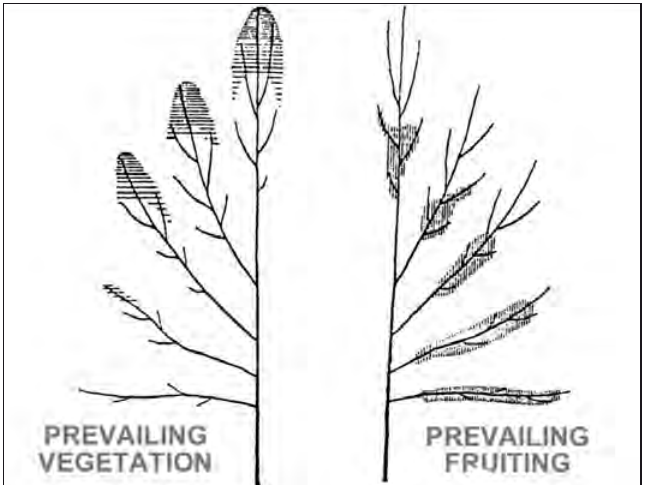
Fig. 6 - In the tree canopy the polymorphims of axes is differently lo - cated. In some parts vegetative structures prevail and in others reproductive structures are predominant (redrawn from Hilken- bäumer,